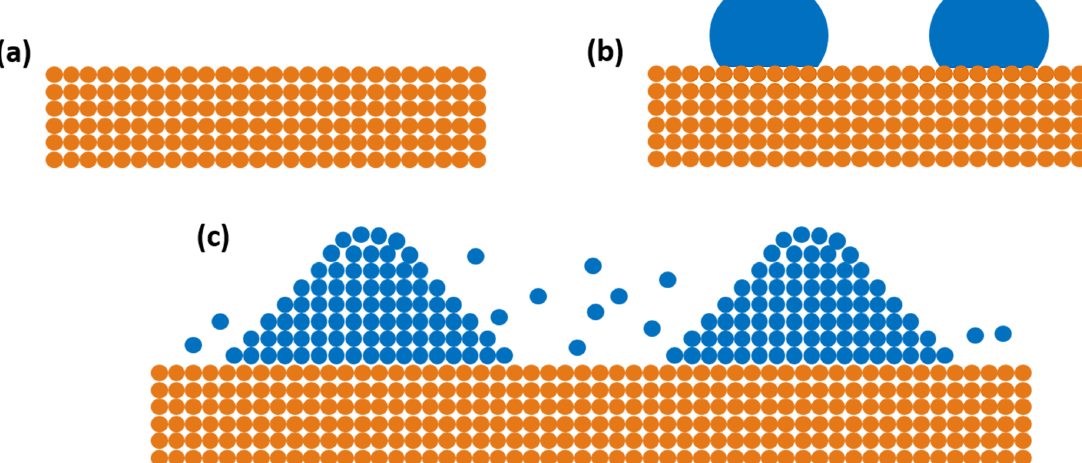
Figure 2. Schematic process showing the formation of DEQDs: ( a ) buffer layer; ( b ) deposition of group III droplets on the surface; ( c ) crystallization of formed droplets in group V rich